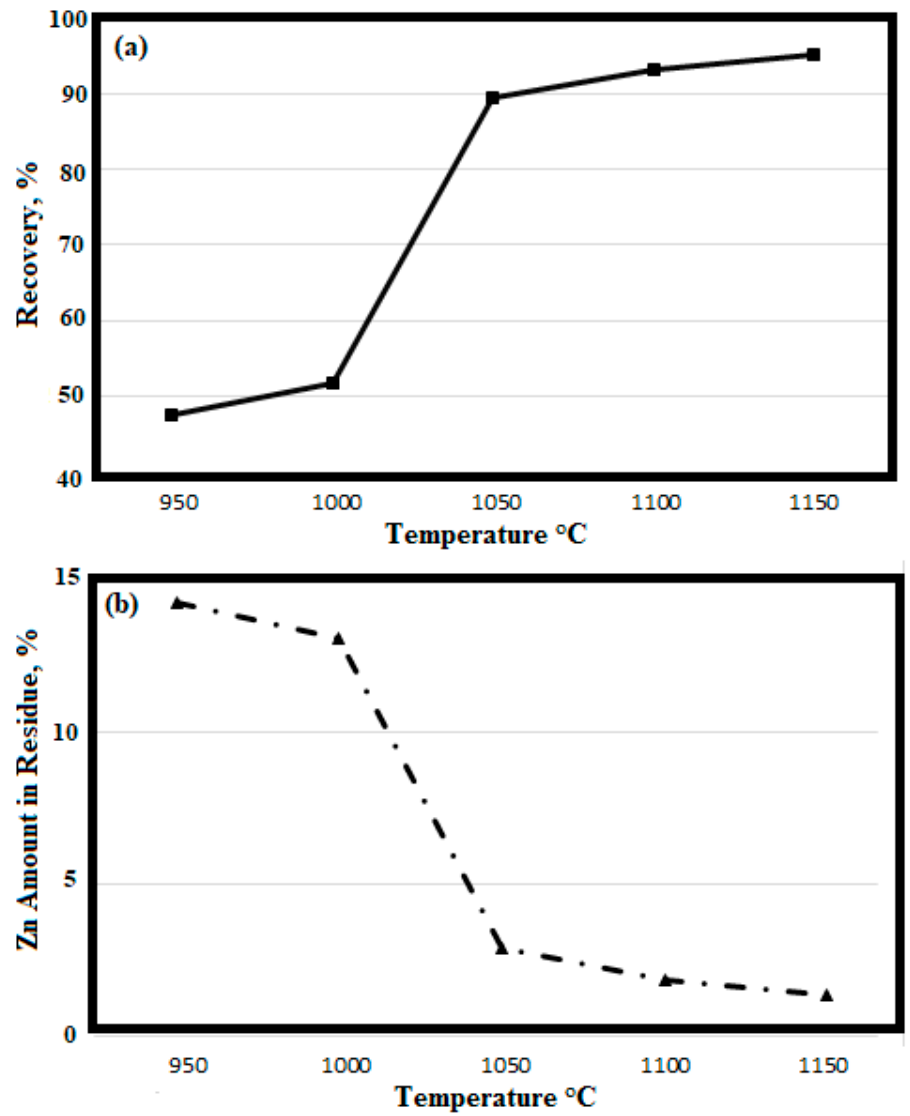
Figure 5. ( a ) Zinc recovery of ambient condition experiments, ( b ) Zn amount in the residue (1 h, various temperature, Ar flow).